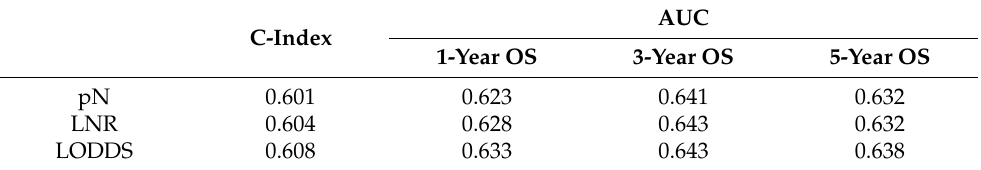
Table 3. Evaluation of the prognostic value of pN, LNR, and LODDS.